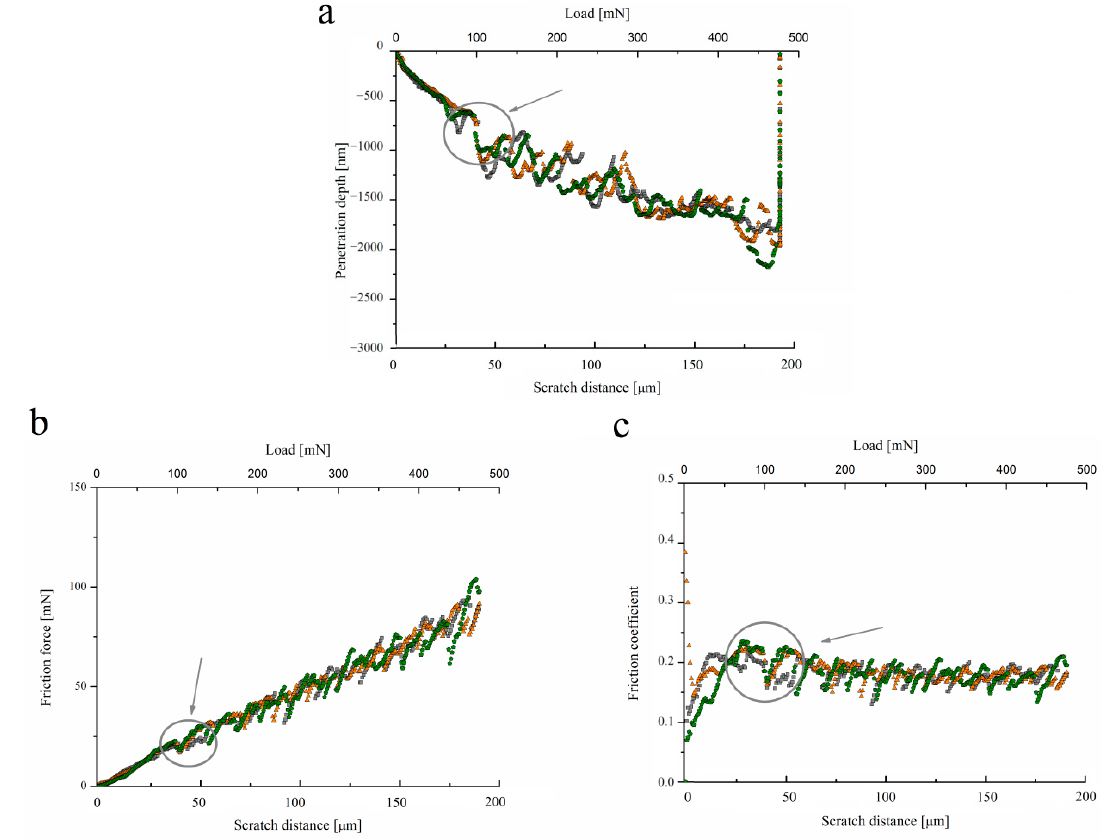
Figure 7. Curves of the high-load scratches. Indenter penetration as a function of scratch distance during loading. ( a ) Penetration depth, ( b ) friction coefficient, and ( c ) friction force as a function of scratch distance. Discontinuities recorded in the experiments are marked with circles and signaled by arrows.